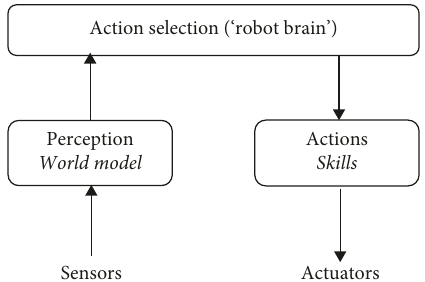
Figure 1: Robot software architecture embodying intelligence: